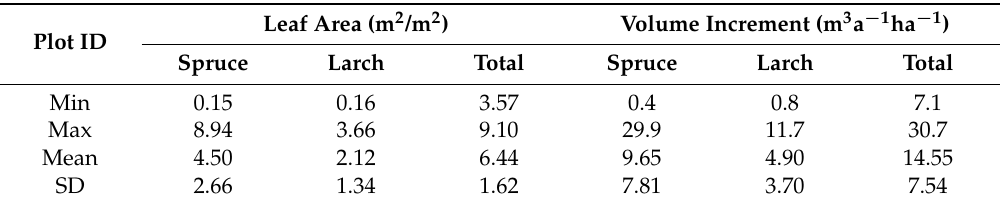
Table 4. Leaf area and annual volume increment of the plots by species. Volume increment is the average increment of the years 2008–2012. SD is the standard deviation.